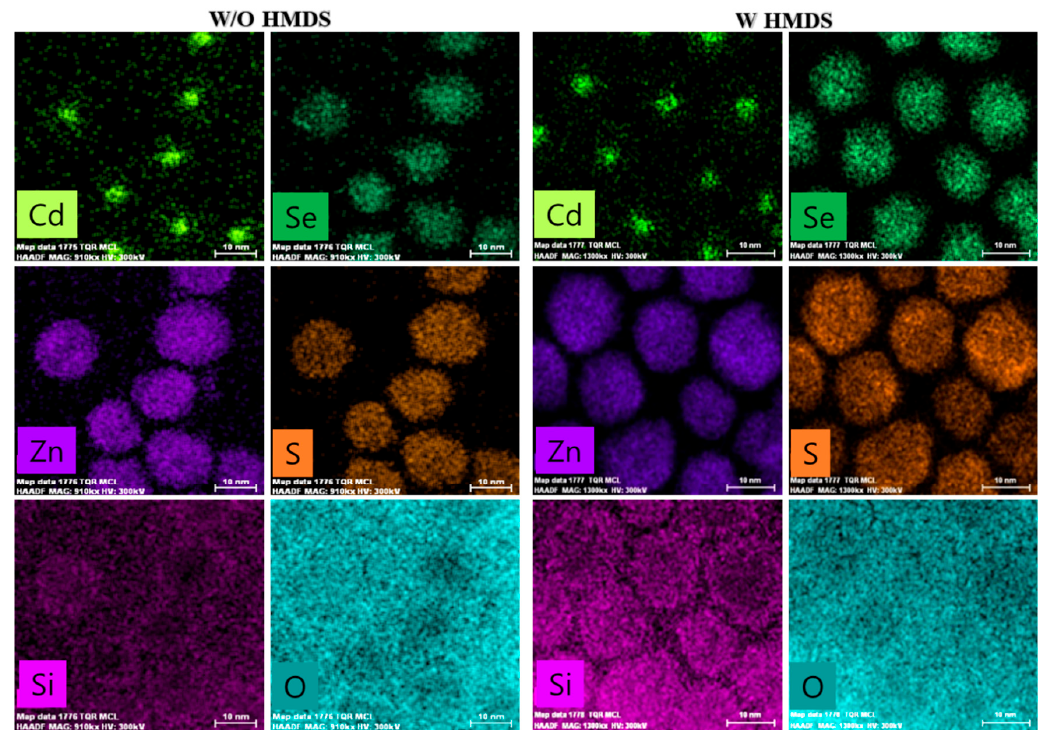
( c ) Colored EDX results for both without (W/O) and with (W) the HMDS treatment process. Note the clear shape of Si elements only in W HMDS (right) samples.